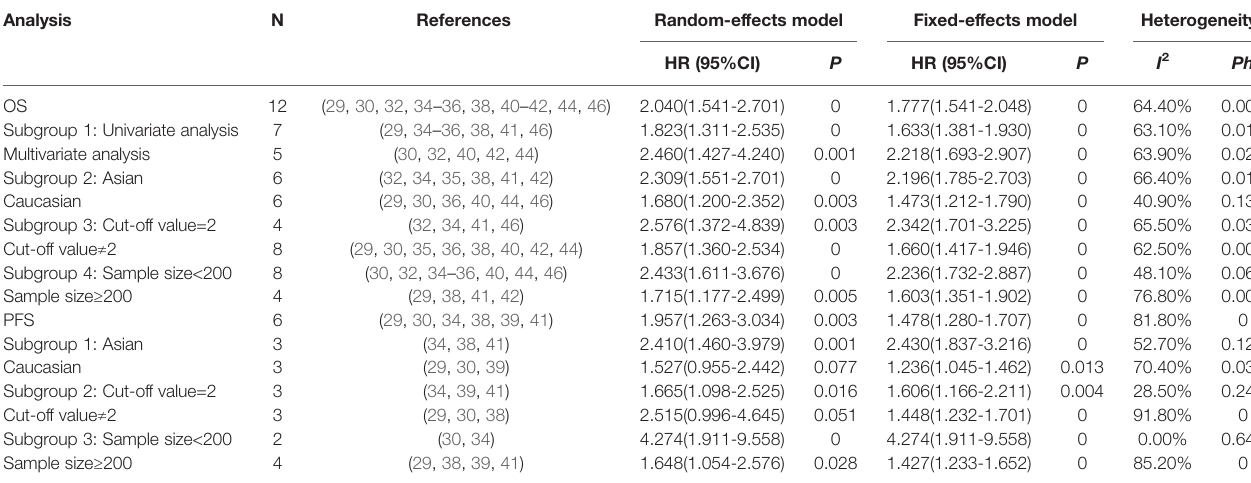
TABLE 2 | Subgroup analysis for OS/PFS in MM patients with high